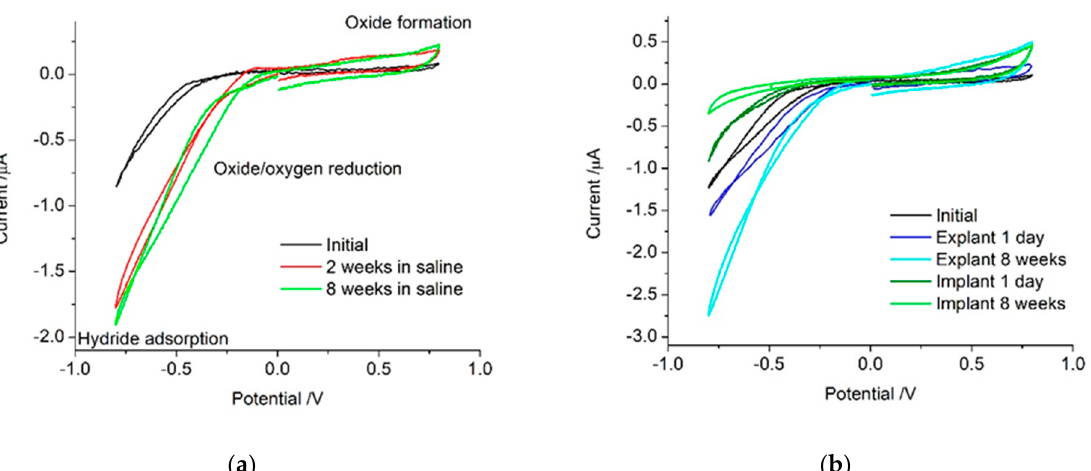
Figure 1. Voltammetric cycle of a platinum cochlear implant electrode from 0 → − 0.8 → 0.8 → 0 V at a scan rate of 20 mV s − 1 : ( a ) electrode tested and stored in saline over 8 weeks and ( b ) electrode initially tested in saline, implanted in a cochlea for 1 day, explanted after 1 day, reimplanted in cochlea for 8 weeks, and explanted after 8 weeks.